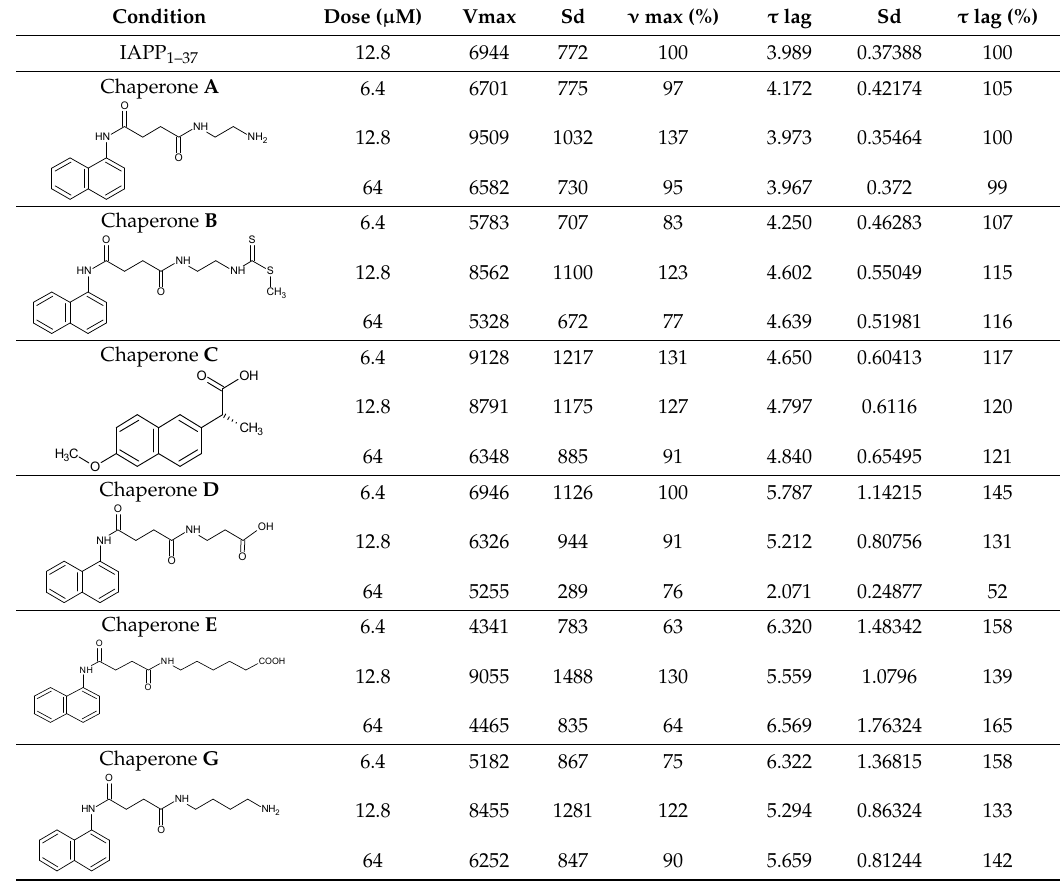
Table 1. Values of ν max and τ lag in IAPP 1–37 aggregation with the incubation of chaperones.